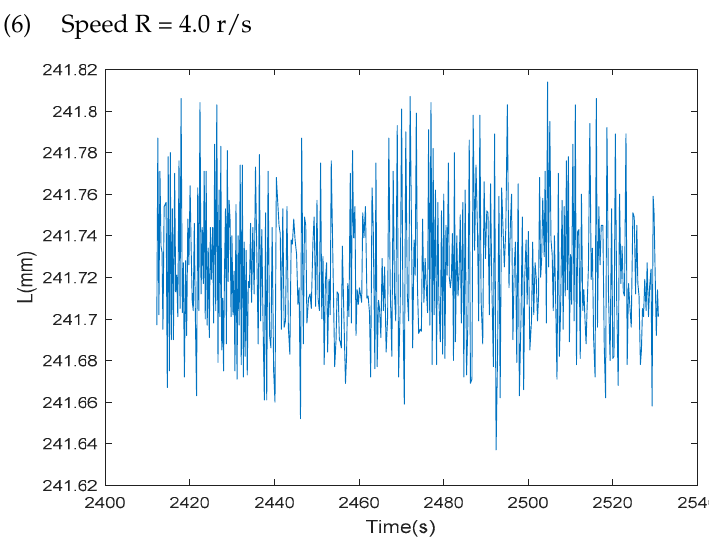
Figure 15. Measurement results of the distance between two targets at 3 r/s. (6) Speed R = 4.0 r/s